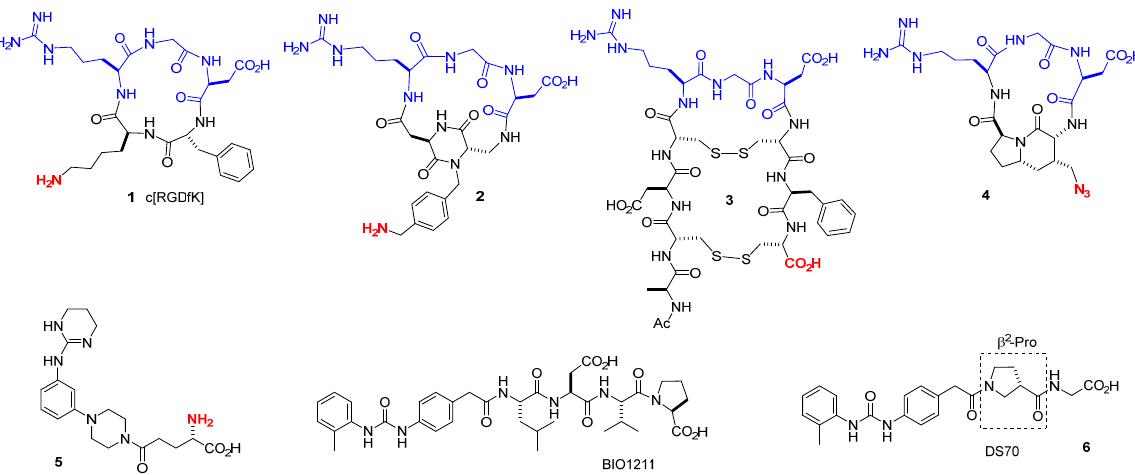
Figure 1. Examples of RGD peptide ( 1 – 4 ) or peptidomimetic ( 5 ) integrin ligands recognized by integrins expressed on cancer cells (e.g., α v β 3, α 5 β 1). Functional groups exploitable for peptide conjugation are rendered in red. The α 4 β 1-integrin selective antagonist BIO1211 contains the LDV binding motif and a diphenylurea moiety. The α / β -hybrid DS70 ( 6 ), designed as an analogue of BIO1211, includes a central β 2 -Pro scaffold.